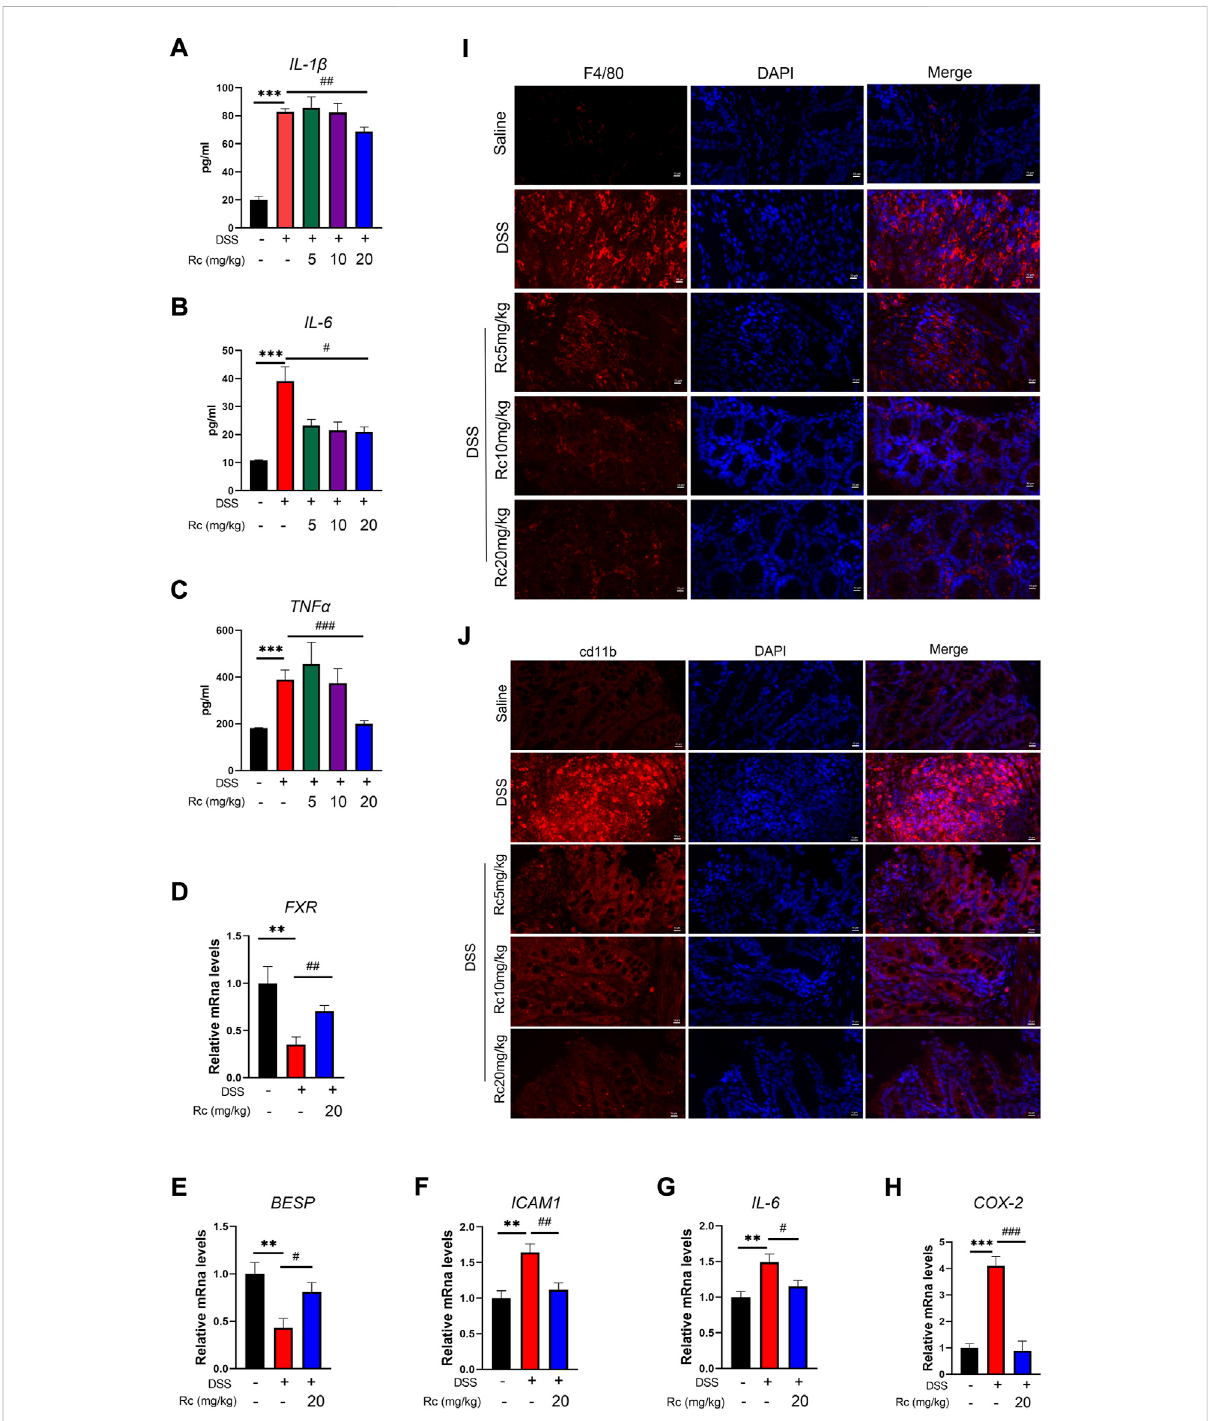
FIGURE 3 Rc suppressed in fl ammation byactivating FXR inDSS-induced in fl amed mouse colons. Serumlevelsof IL-1 β , IL-6and TNF- α (A – C) ;thecolons werecollected for qPCRanalysis,and therelativemRNAlevels of FXR (D) , BSEP (E) , ICAM (F) , IL-6 (G) ,and COX-2 (H) weremeasured;representative imagesofimmuno fl uorescenceofF4/80 (I) andcd11b (J) inmousecolonsections(magni fi cation:200×).Dataareshownasthemean±SEM( n =8). * p < 0.05, ** p < 0.01, *** p < 0.001 vs . the saline group; # p < 0.05, ## p < 0.01, ### p < 0.001 vs . the DSS